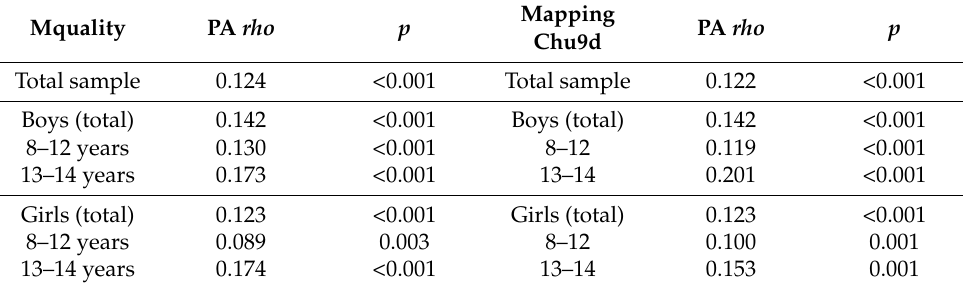
Table 4. Association between HRQoL (Mquality and Mapping Chu9d) and